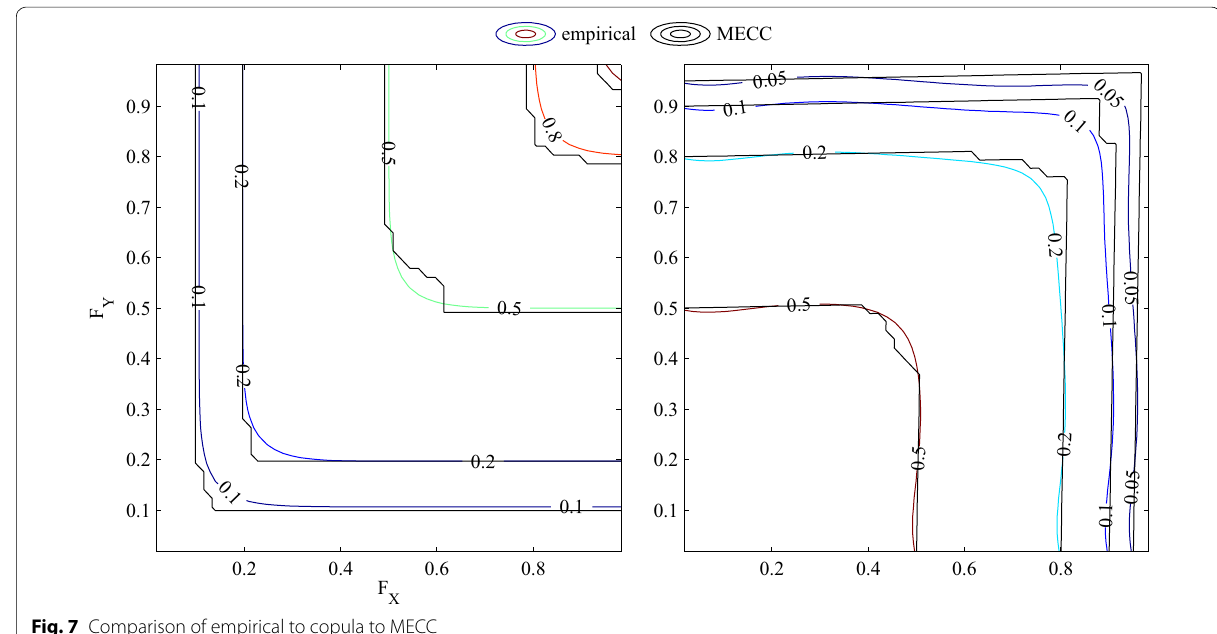
Fig. 7 Comparison of empirical to copula to MECC